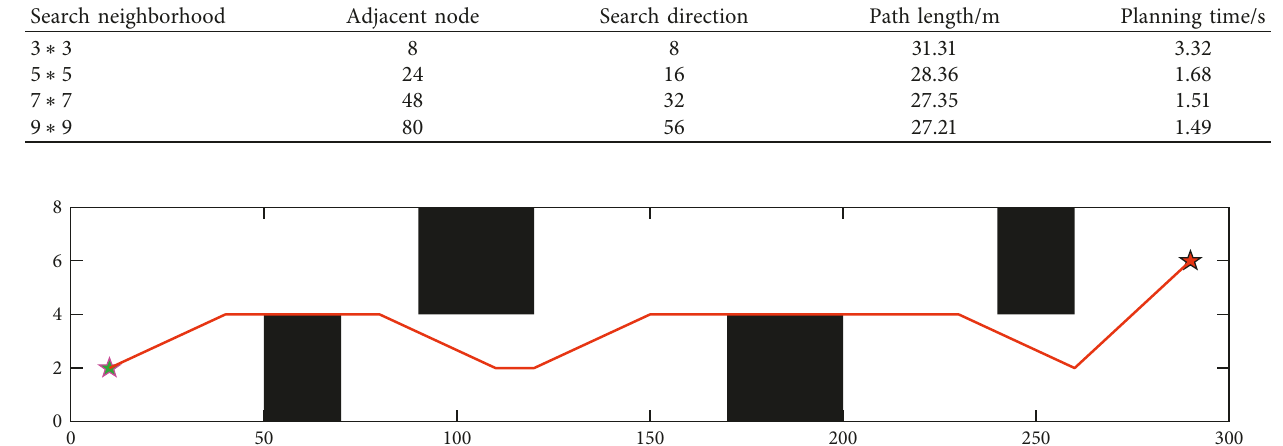
Figure 8: Improved A ∗ algorithm planning